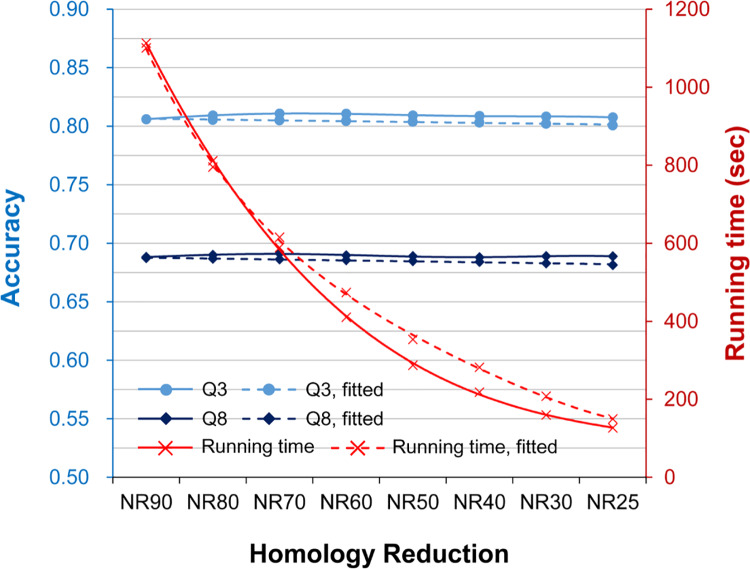
The average time cost and accuracy of the assessed secondary structure prediction methods as the sequence homology of the target dataset reduces.The horizontal axis is the extent of homology reduction in sequence identity non-redundancy. For example, NR90 means that any two sequences in the PSSM target dataset share <90% identities. The lowest sequence identity was 25% because when a lower identity such as 20% was applied, the number of sequences remaining in the target dataset would be far smaller than the 5 million safety zone (see Fig 2 and S6 Table) and then cause unreasonable decreases of the accuracy. The right vertical axis is the time cost (red), and the left is the accuracy (blue). The dotted red curve plots the expected time cost according to the Eq (1) formulated in the experiment of target size reduction. Because as the homology of the target dataset was reduced the dataset was also significantly shrunk, the time cost of SSP methods decreases rapidly. The dotted light and dark blue curves were the expected values of Q3 and Q8 made according to the size-reduction accuracy Eqs (2) and (3), respectively, while the solid blue curves showed the actual values. Very interestingly, as the target dataset homology reduced, the accuracy increased slightly.